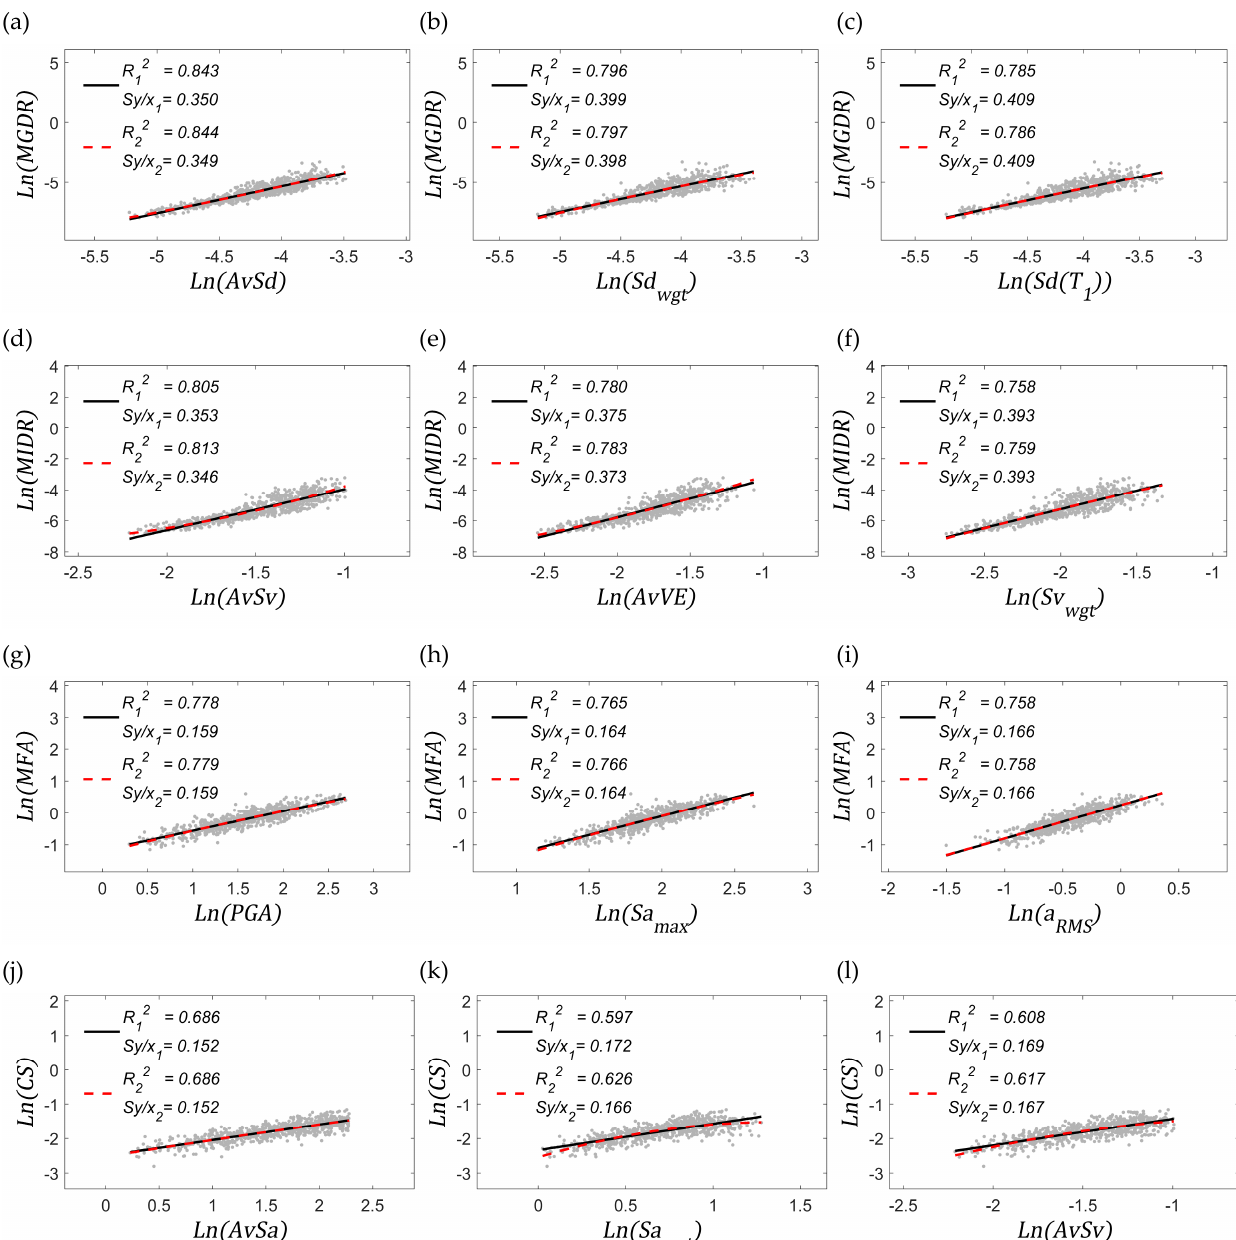
Figure 7. ( a – l ) Statistical properties calculated with inelastic results; in these figures 𝑁 (cid:3010)(cid:3014) is equal to